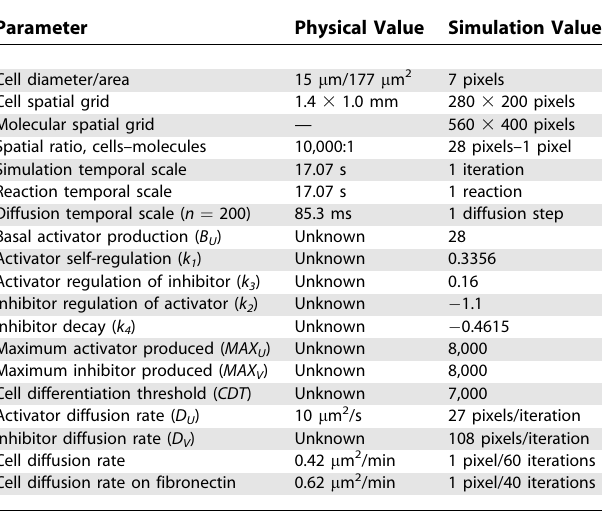
Table 2. Calibrated Simulation Parameters to Known Physical Values